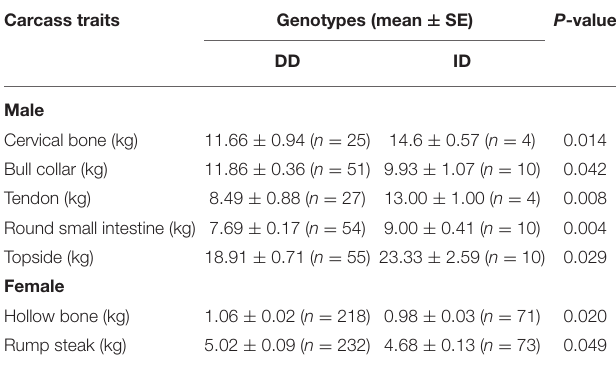
TABLE 4 | Association of the 12 bp indel within bovine LOC100847835 promoter region and carcass traits of Shandong black cattle.